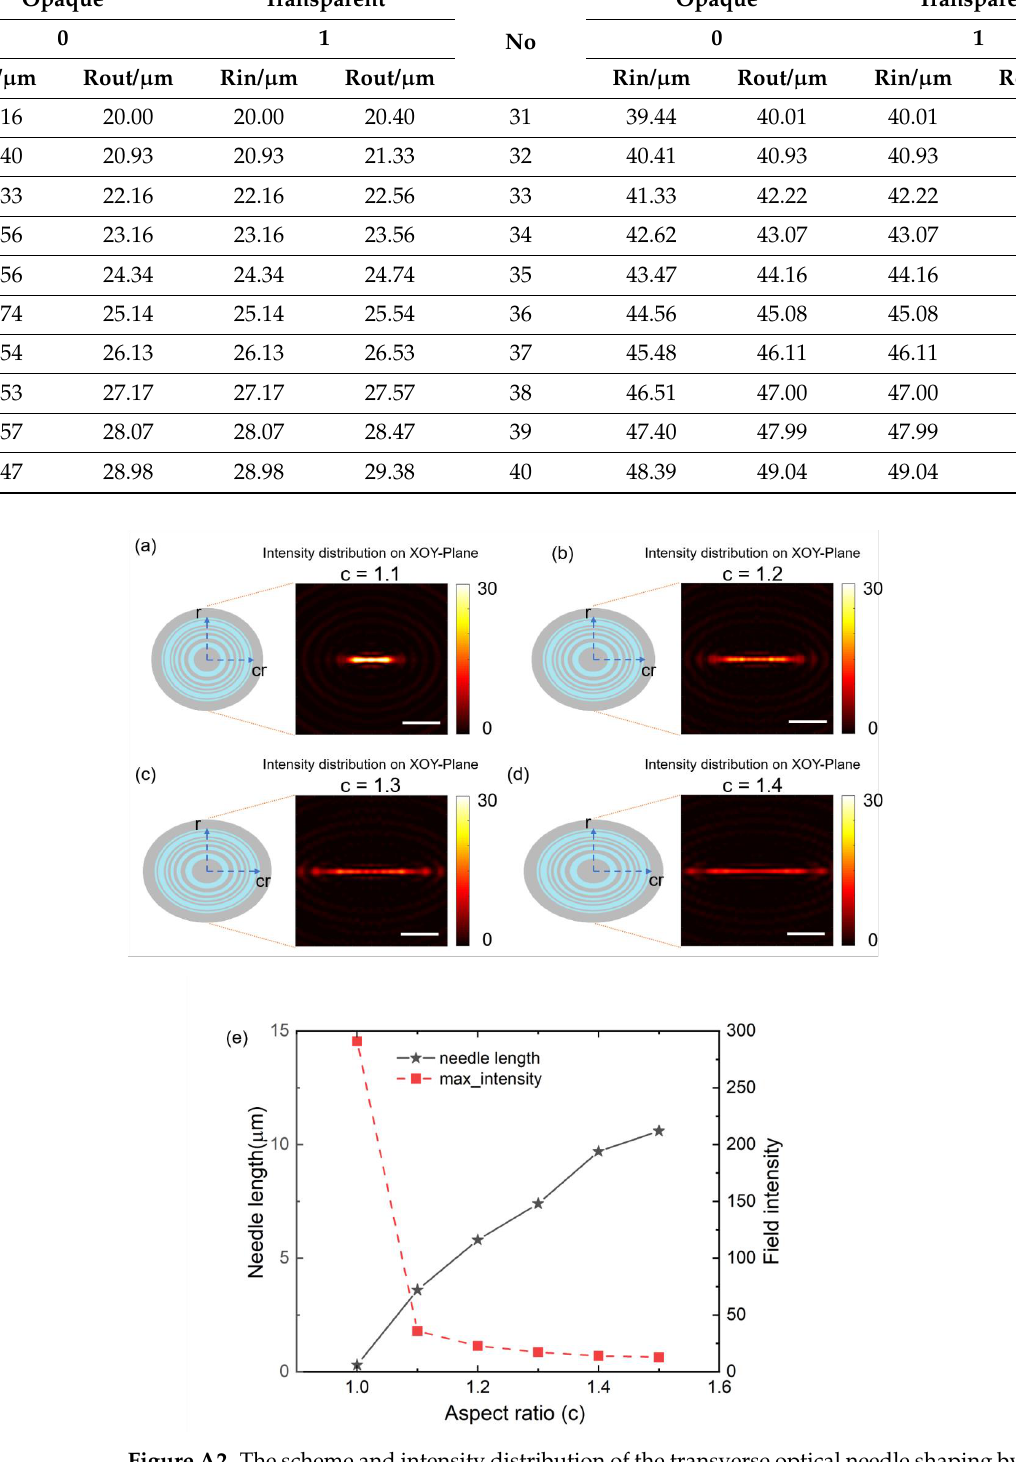
Figure A2. The scheme and intensity distribution of the transverse optical needle shaping by elliptical SCL with different aspect ratios ( a – d ). Scalebar: 350 nm. It can be seen from the statistic chart ( e ) that as the aspect ratio c increases from 1.0 to 1.4, the length of the transverse needle will be increased, but the light field intensity in the needle region will be dropped. To reach a compromise between the length and intensity of the optical needle, the aspect ratio value of 1.2 is chosen in our design. Table A1. The position information of each belt for elliptical supercritical lens